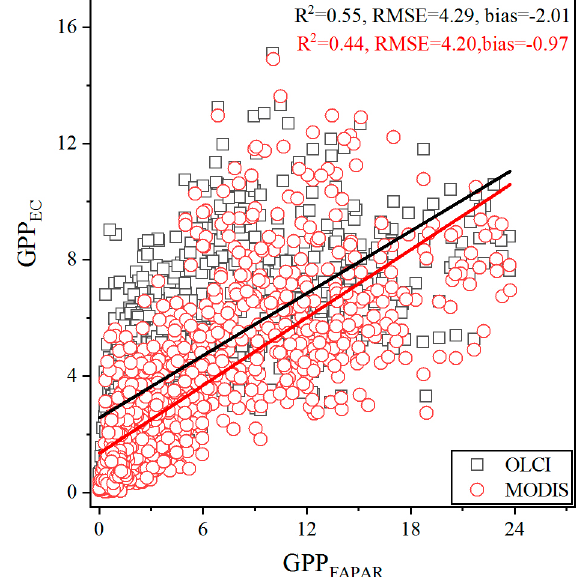
Figure 10. Scatterplots between GPP EC and GPP MODIS-FAPAR for all sites in 2017 and 2018. Significance levels: p < 0.001. ( a – g ) represent the sites the same as Figure 2.